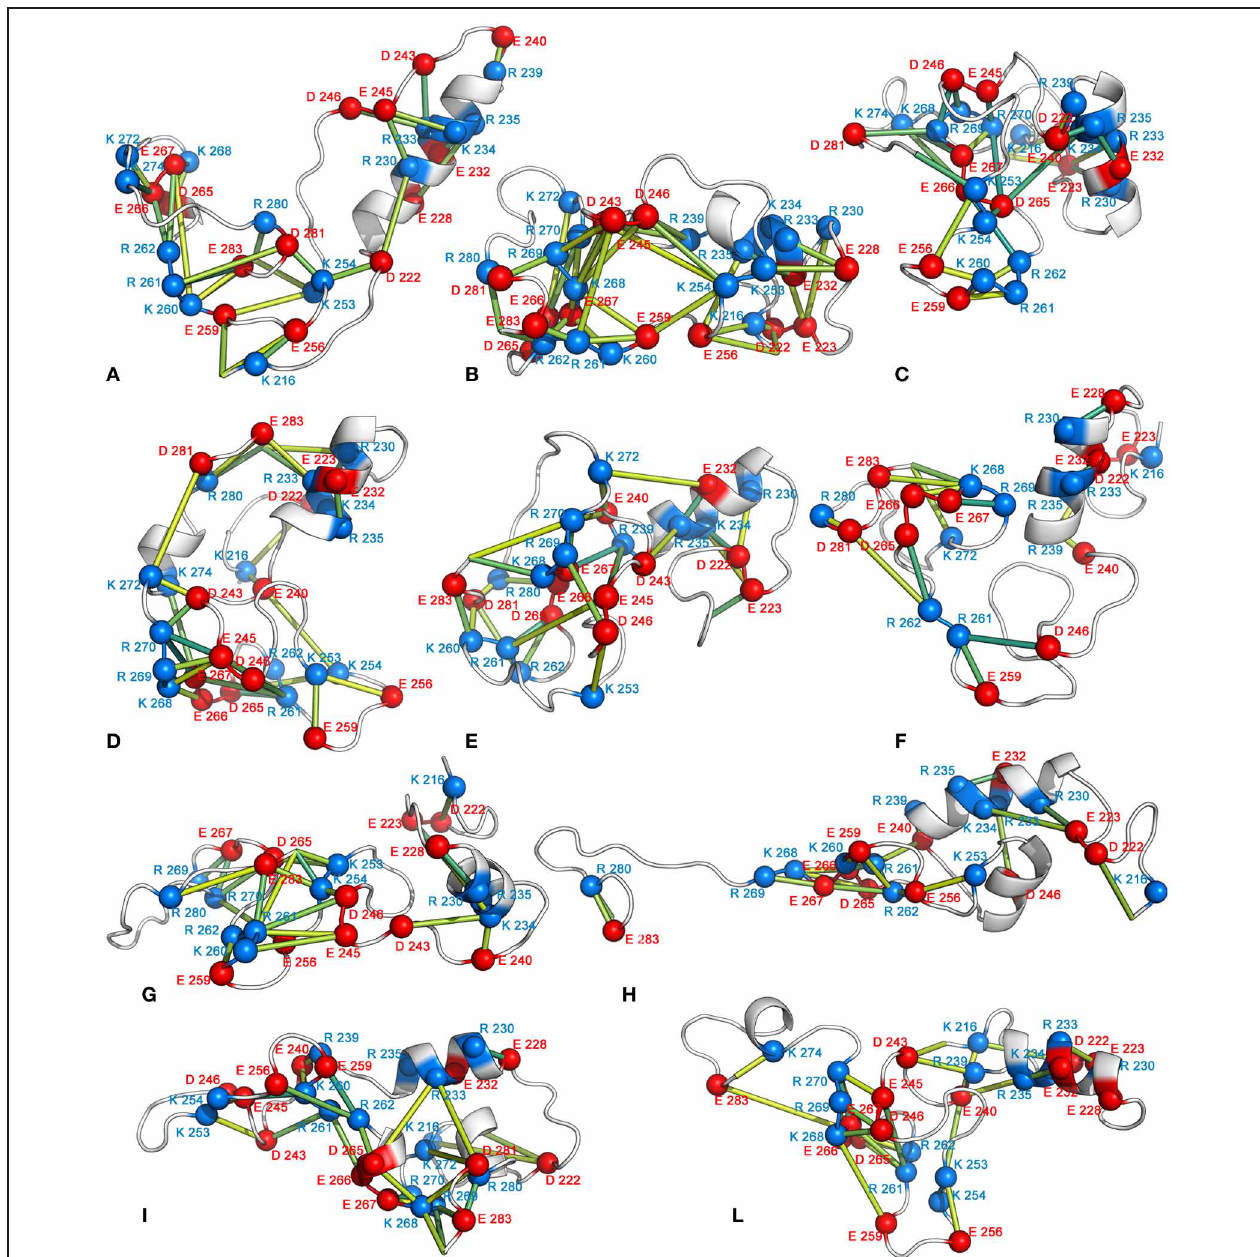
FIGURE 9 | Networks of salt bridges. The 3D average structure of each FEL basin is shown as cartoon, and the C α atoms of the acidic and basic residues involved in salt bridges are shown as red and blue spheres, respectively. The